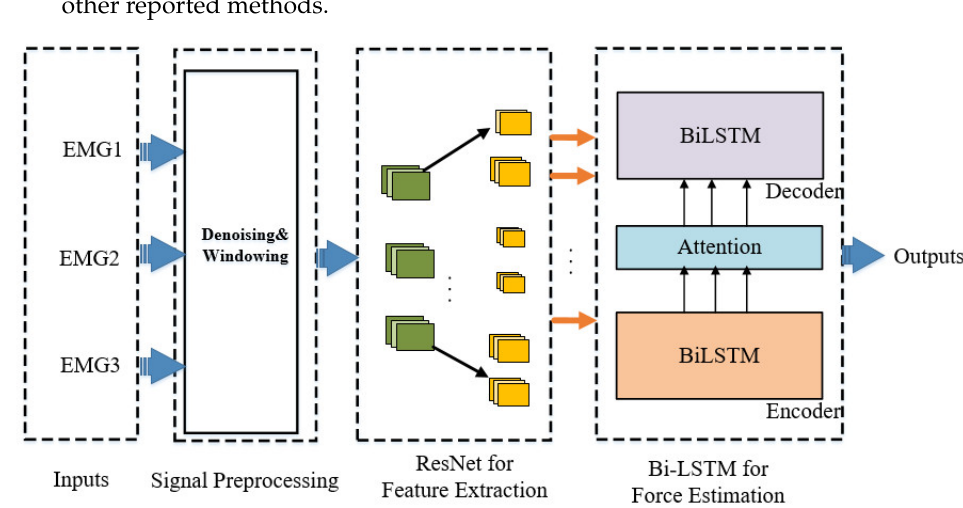
Figure 1. The framework of our method.